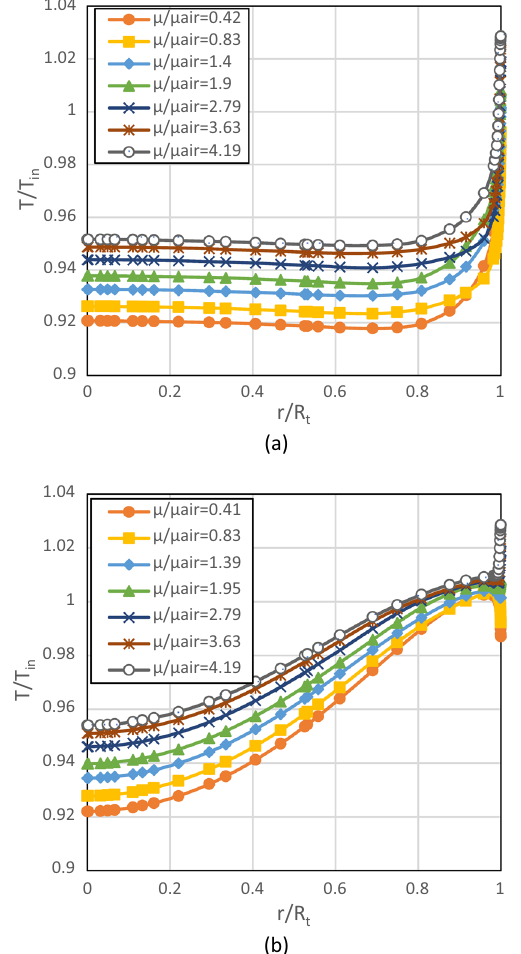
Fig. 21 Dimensionless temperature profiles versus dimensionless radial direction plotted at z∕L = 0.63 for various dynamic viscosity ratios. a Static and b Total temperatures with 400 kPa at the inlet, 0 kPa at the cold outlet and 30 kPa at the hot outlet